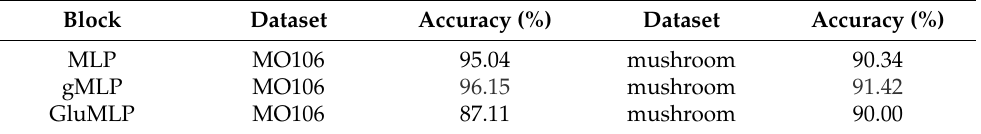
Table 4. Effect of different MLPs on the model at different locations.